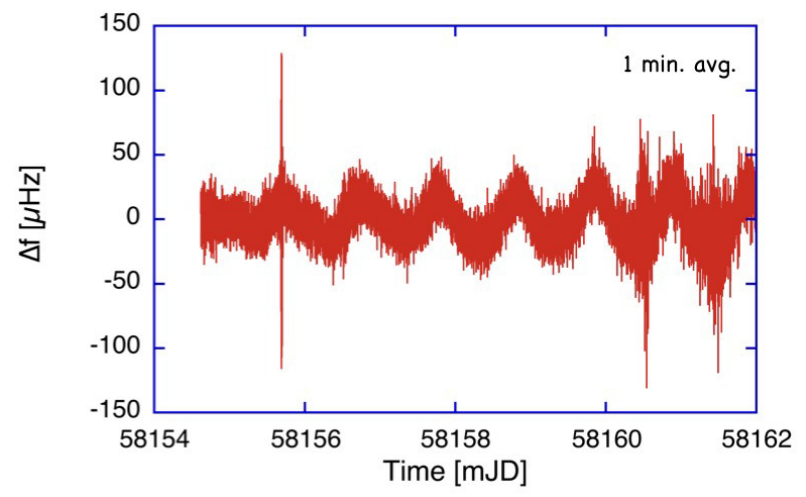
Figure 6. One-minute averages of the recorded Earth rotation rate of the G ring laser at the Geodetic Observatory Wettzell. The rms scatter corresponds to 30 µ Hz of scatter for the beginning of the time